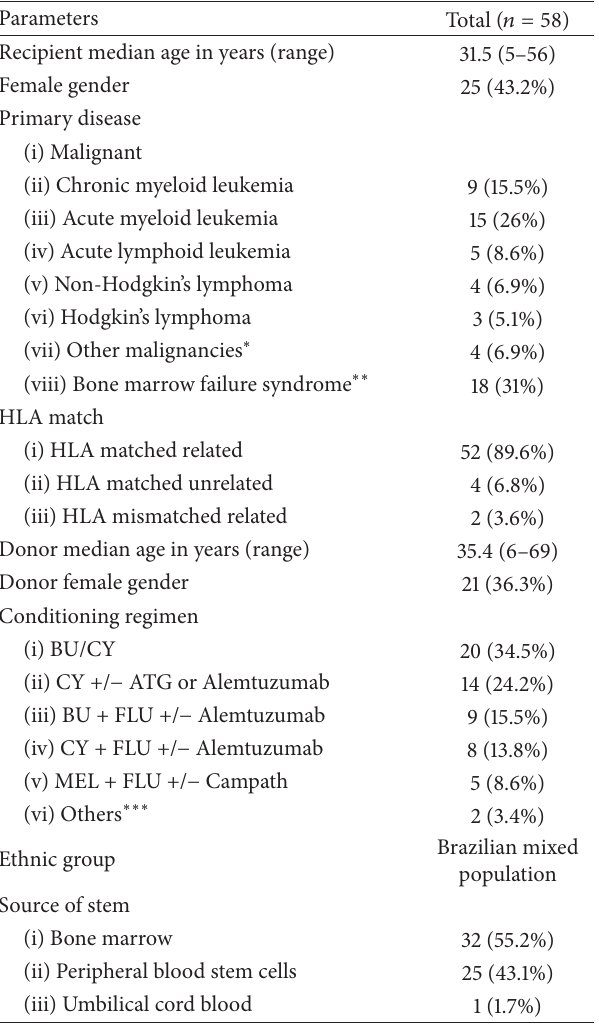
Table 1: Clinical characteristics of allo-HSCT patients and donors ( 𝑛 = 58